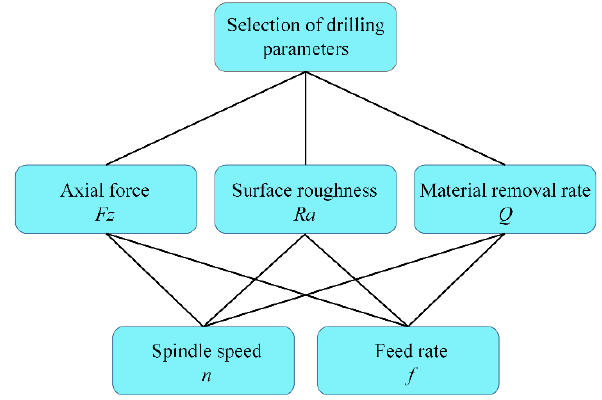
Figure 17. Optimizing